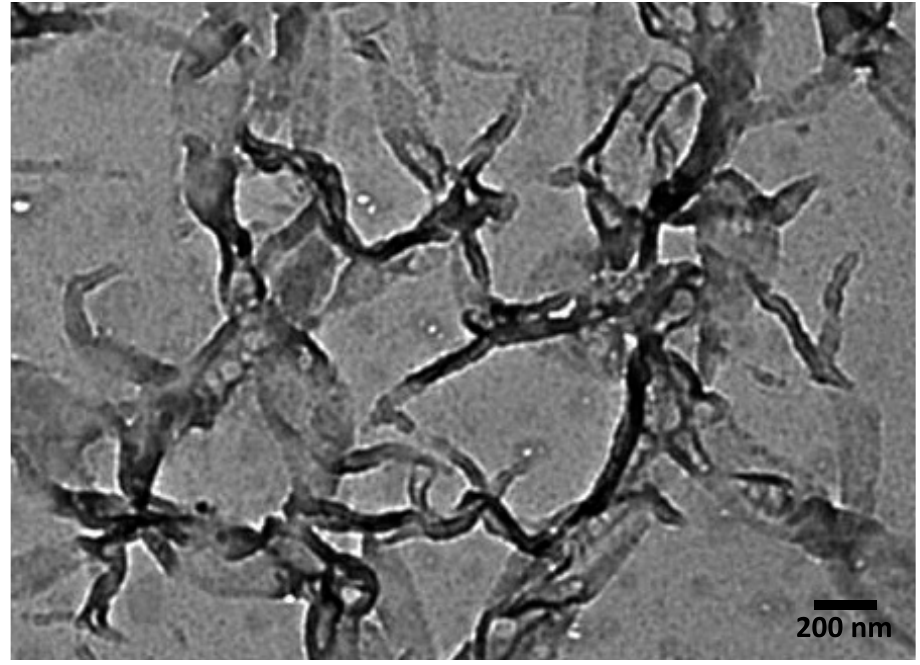
Figure 6. TEM image of